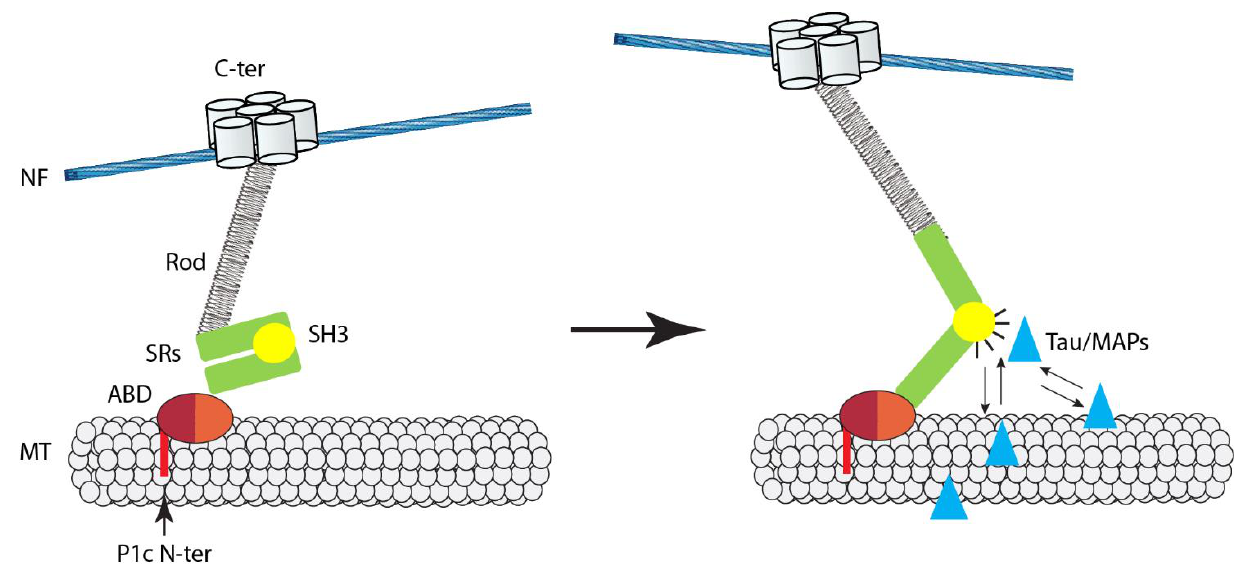
Figure 2. Hypothetical model depicting isoform P1c as a mechanosensitive regulator of MT dynamics in neurons. Binding of NF-associated P1c to MTs occurs via its isoform-specific N -terminal sequence (P1c N -ter) and the adjoining ABD; note: the ABD of the P1c variant expressed in neurons is of the 2α/3α type (see text). Left, without strain, the SH3 domain, embedded within the spectrin repeats (SRs) of the plakin domain, is autoinhibited (i.e., inaccessible to binding proteins) through its internal interaction with SR4. Right, on mechanical force (central large arrow), SRs partially unfold, exposing the SH3 domain on the exterior of the molecule and making it accessible to interacting proteins, such as tau and other MT regulators. Such interactions may lead to alterations in MT dynamics in response to strain. (For details see text).